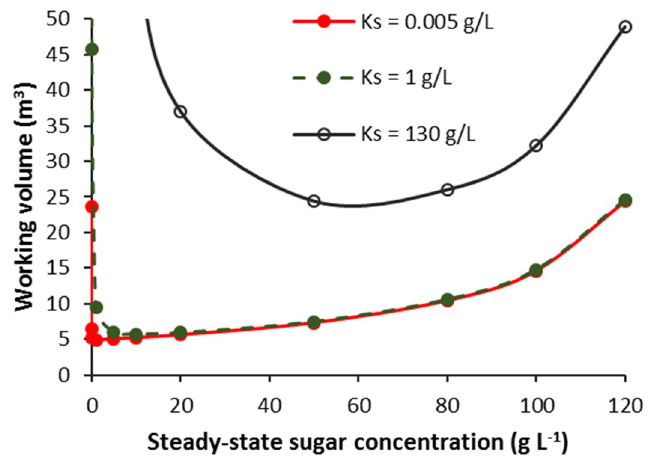
Figure 5. Effect of K S and steady-state sugar concentration on the working volume of a CSTB. Figure 5. E ff ect of K S and steady-state sugar concentration on the working volume of a